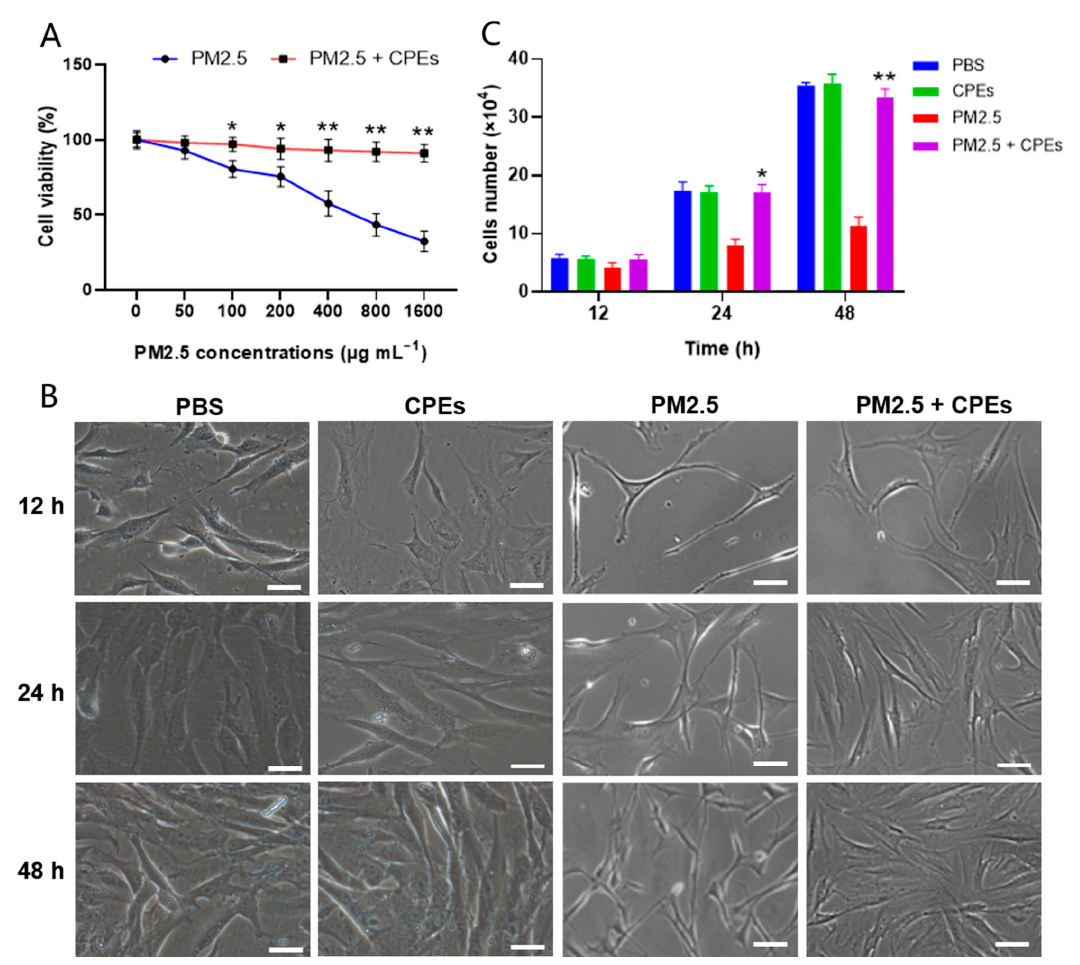
Figure 4. Cytotoxicity of PM2.5 on human skin fibroblasts and protective effect of CPEs in cell viability. ( A ) Fibroblasts were treated with increased concentrations of PM2.5 for 24 h, and CPEs (10 mg mL − 1 ) were added. ( B ) Changes in morphology of fibroblasts at 12, 24 and 48 h after addition of PM2.5 (100 µ g mL − 1 ) or plus CPEs (scale bar: 50 µ m). Cell viability was determined by MTT